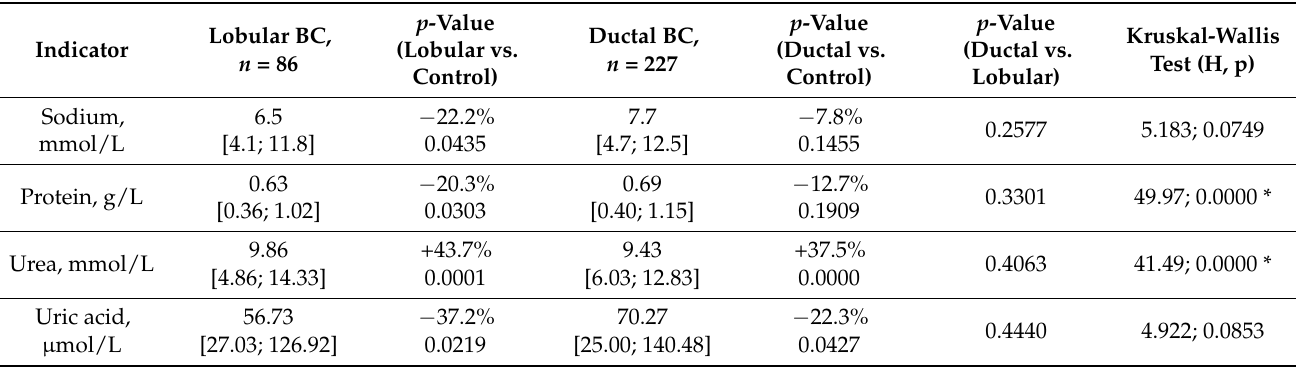
Table 4. Biochemical composition of the saliva of patients with breast cancer, depending on the histological type.